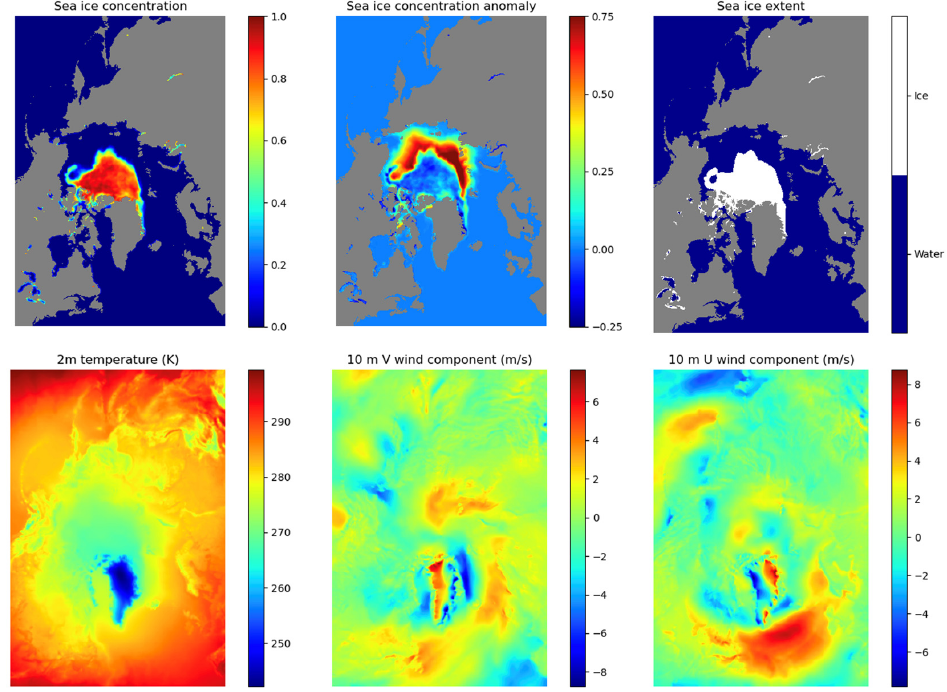
Figure 1. Examples of co-registered (top row) sea ice and (bottom row) atmosphere-related images. All images are mapped onto a polar stereographic 25-km grid.